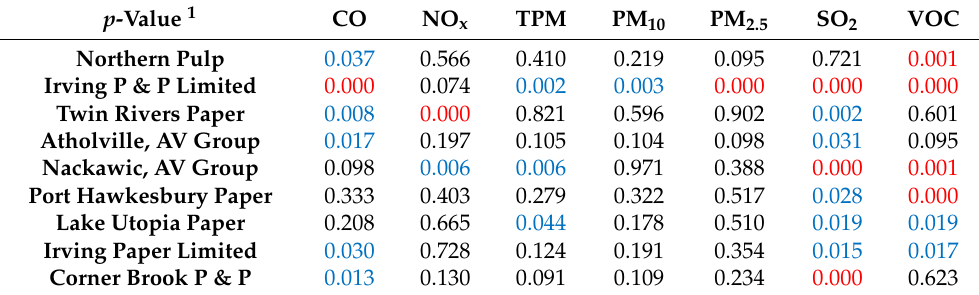
Table 4. p -values for the NPRI annual